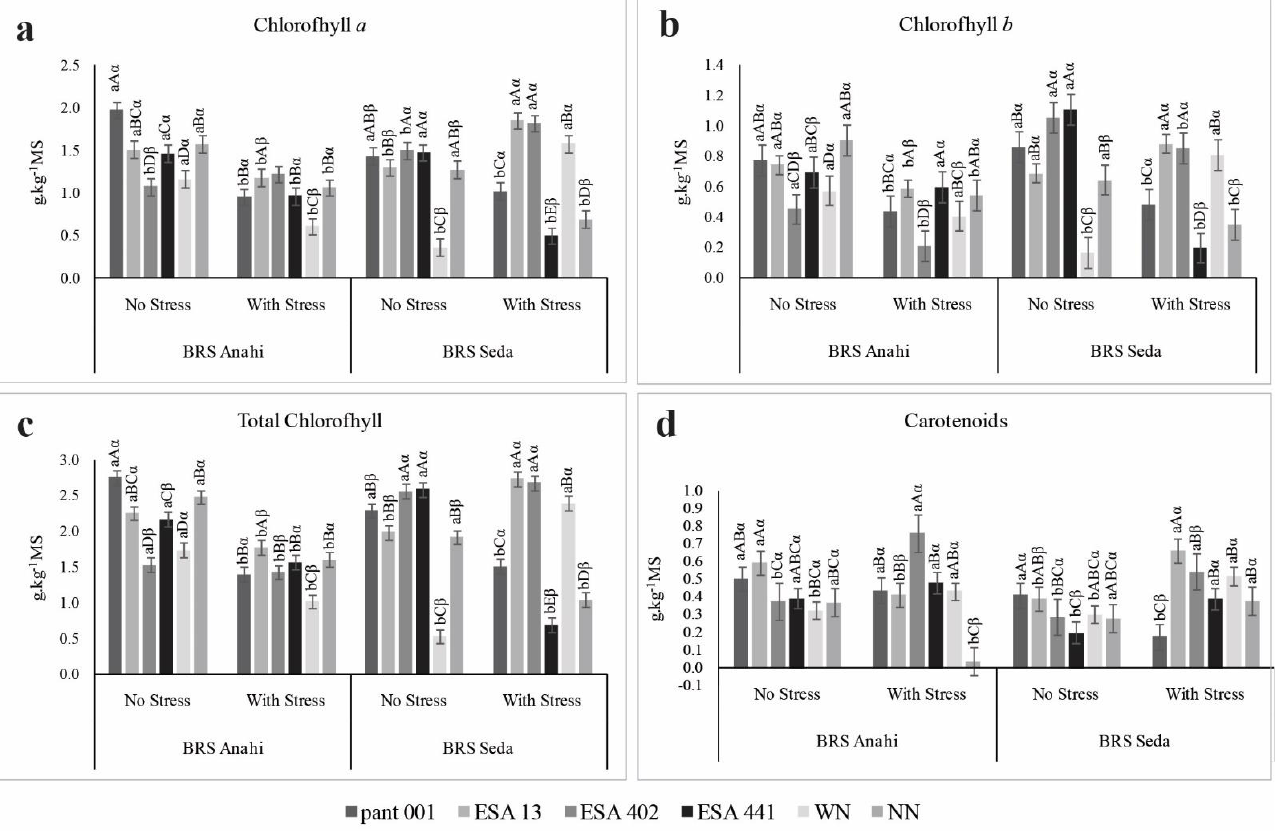
Figure 9. Photosynthetic pigments: chlorophyll a ( a ), chlorophyll b ( b ), total chlorophyll ( c ), and carotenoid ( d ) in sesame plants (BRS Seda and BRS Anahí) inoculated with bacilli, under water deficit. WN-with nitrogen and NN-no nitrogen. Table 1. Summary of the main physiological and biochemical variables analyzed in the interaction between the two sesame genotypes (BRS Anah í and BRS Seda) and the bacilli-based